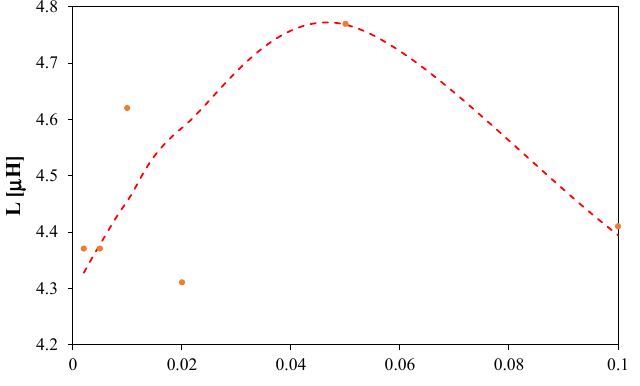
Figure 10. Calculated and measured dependences of the electrolyzer inductance on the electrolyte concentration.